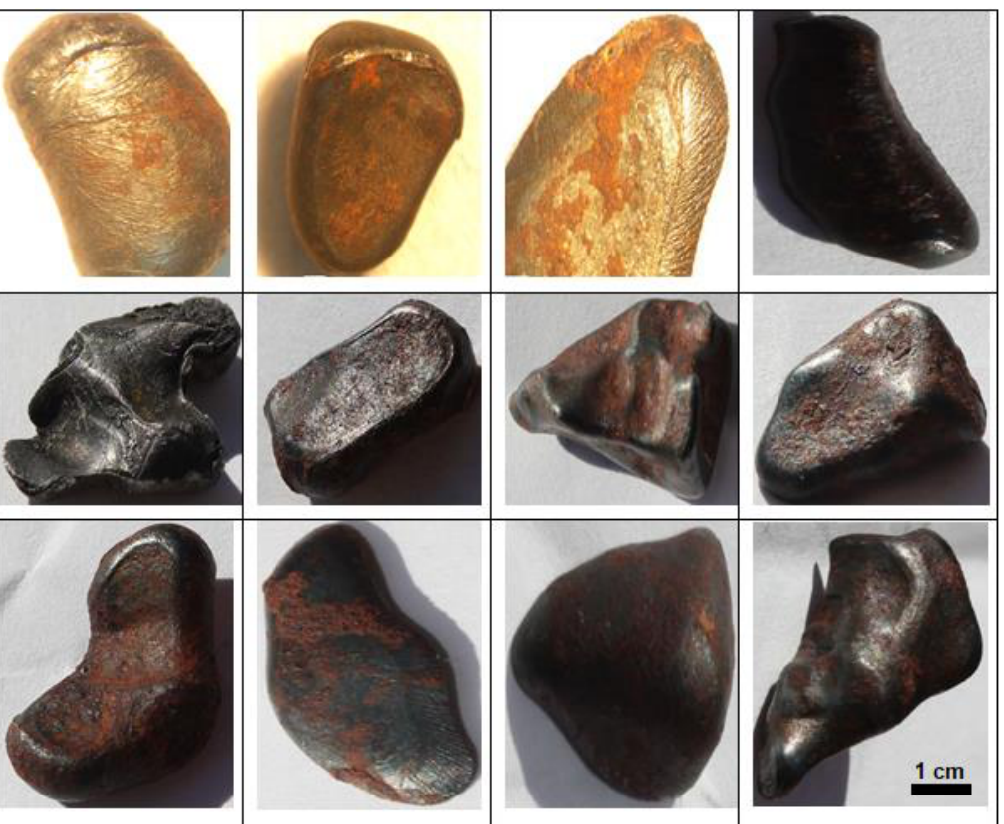
Figure 4. Physical characteristics of individual samples of the Oglat Sidi Ali iron meteorite.